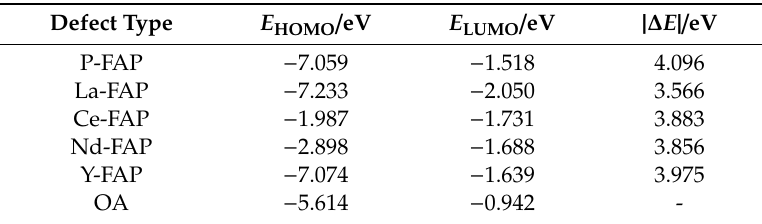
Table 4. Frontier orbital energies of the REE-FAP crystals and